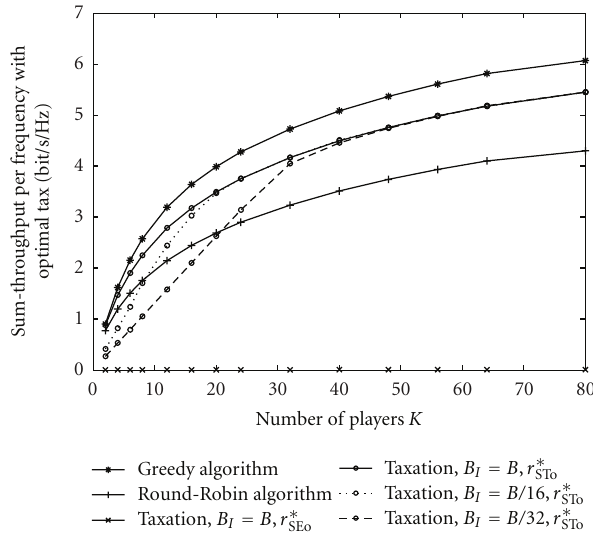
Figure 6: Optimal tax rate for sum throughput r ∗ number of competing players for the SelBM and the SocBM; two- path channel model.